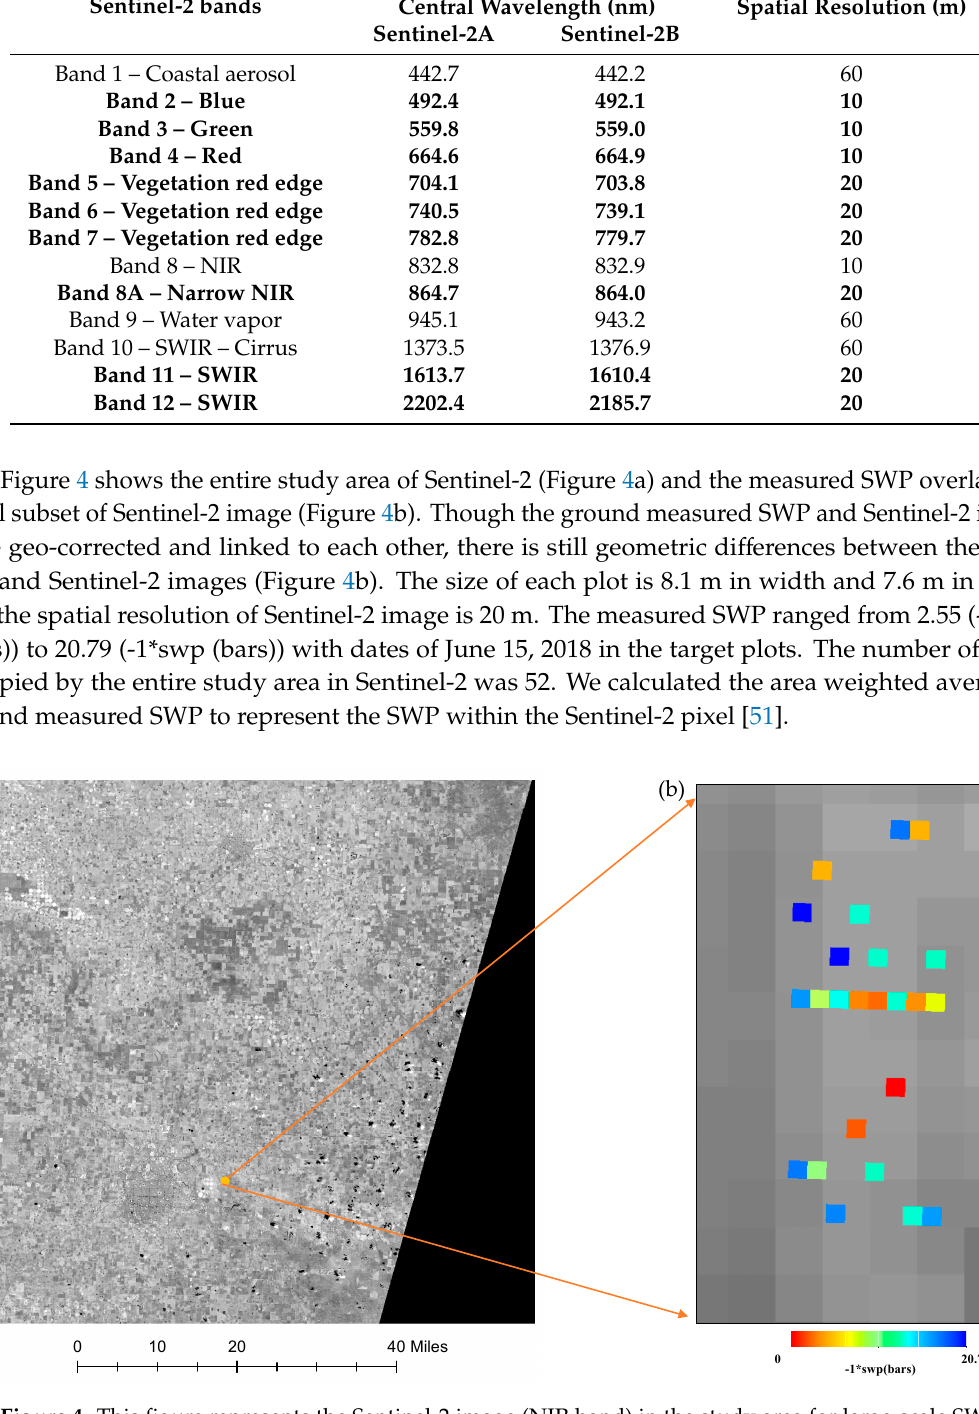
Figure 4. This figure represents the Sentinel-2 image (NIR band) in the study area for large-scale SWP estimation ( a ) and the measured SWP of target plots overlay on a small subset of Sentinel-2 NIR band image( b ). The color layer ( b ) represents the amount of SWP of each plot collected on June 15, 2018.